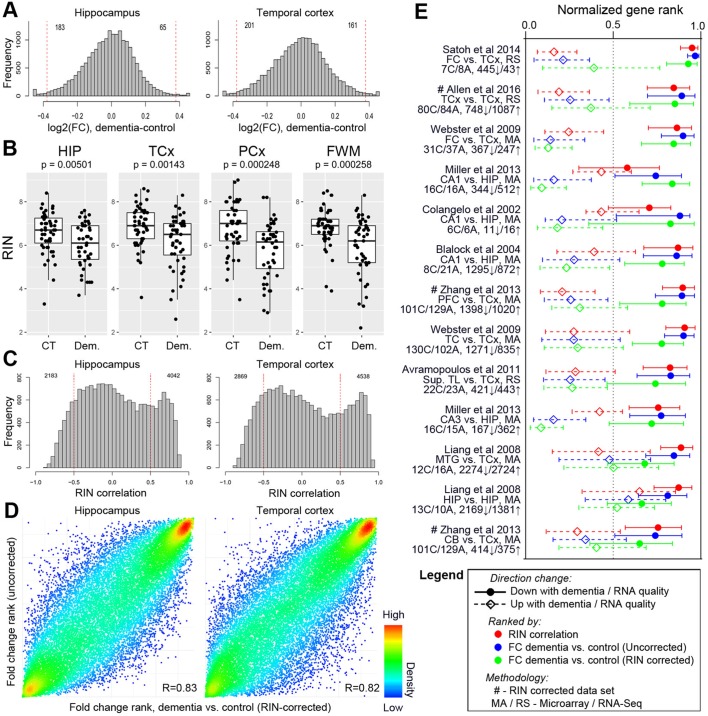
Differences in RNA quality between dementia and controls greatly impact gene expression results.(A) Gene expression differences between donors with and without dementia in uncorrected data. Histograms show the distribution of log2(fold difference) expression levels (x-axis) between control and dementia donors in two brain regions (hippocampus, left; temporal cortex, right). Numbers indicate how many genes have a fold change > 1.3 (red lines) and p<0.05. (B) RNA quality in donors with dementia (Dem.; right bars) is significantly lower than in non-demented controls (CT; left bars) in all four brain regions. Y-axes are RIN values. Plots as in Figure 2B–D. (C) Gene expression levels for many genes are highly correlated with RIN, with more showing lower expression with lower RNA quality (positive values) than with higher RNA quality (negative values). Histograms show the distribution of RIN correlations in two brain regions. Numbers indicate how many genes have R > 0.5 (red lines) and p<0.05. (D) Rank order of fold differences between controls and dementia cases is largely unchanged after controlling for RNA quality. Ranked fold differences on the x- and y-axes correspond to Figure 6A and Figure 5A, respectively. Dots indicate genes and are color-coded by density. (E) Genes with higher or lower expression levels in people with dementia compared with cognitively normal older adults from 12 brain regions in eight previous studies (rows) are related to dementia diagnosis and RNA quality in this study. Horizontal tics show the 25th percentile, median, and 75th percentile rank of the indicated dementia-related list in our current data set. Gene expression levels from genes lower in low RIN samples are also lower in AD samples from the comparison studies (red, solid lines are shifted towards 1), while gene expression levels from genes higher in high RIN samples are also higher in AD samples from the comparison studies (red, dotted lines are shifted towards 0). Gene expression results accounting for RIN (green) generally agree less well between studies than results not accounting for RIN (blue). See also Figure 6—figure supplements 1–2 and Figure 6—source datas 1–6.10.7554/eLife.31126.023Figure 6—source data 1.Log2 fold changes between AD vs. control and dementia vs. control for each gene in all four brain regions, along with associated SVA p-values.Results for both RIN corrected and uncorrected data are shown.10.7554/eLife.31126.024Figure 6—source data 2.Correlations between each gene and RNA quality (RIN) with associated SVA p-values in all four brain regions.10.7554/eLife.31126.025Figure 6—source data 3.Significant GO terms for genes increasing or decreasing expression with decreasing RNA quality.Up to 50 significant categories for molecular function (MF), cellular component (CC), and biological process (BP) are shown, after correction for multiple comparisons.10.7554/eLife.31126.026Figure 6—source data 4.Description of nine previous studies comparing AD vs. control, including details of how gene lists used in paper were derived.10.7554/eLife.31126.027Figure 6—source data 5.List of 26 gene lists from the nine above publications that are used in Figure 6E.10.7554/eLife.31126.028Figure 6—source data 6.Significance of association between each of the first 25 principal components and every assessed metric in the un-normalized and RIN-normalized data.SVA P-values (Bonferroni corrected) are shown. Only metrics with at least one significant association in any region in either the un-normalized or RIN-normalized data are included in the table.